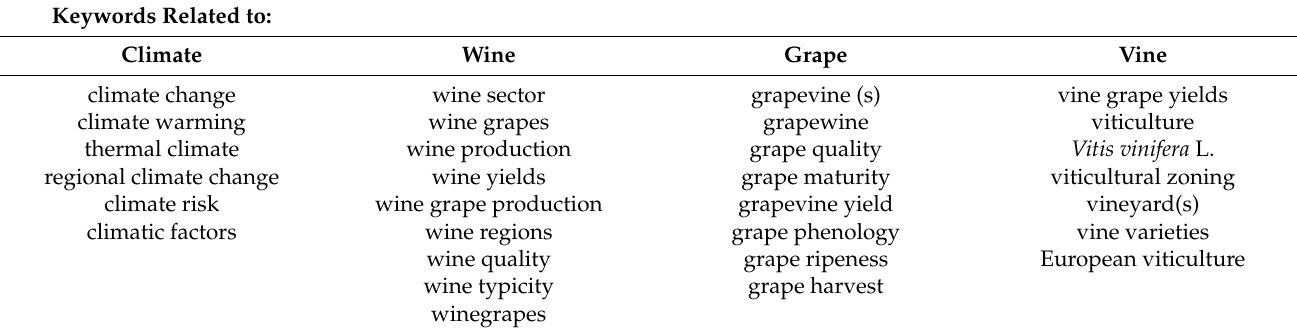
Table 1. Keywords utilised for the implementation of multiple search queries.